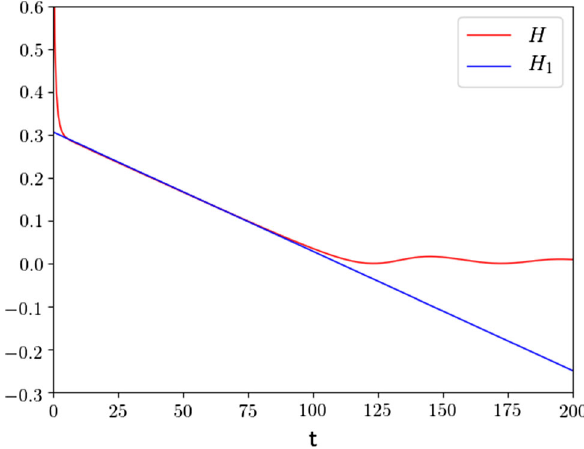
Fig. 1 It is shown in red the exact numerical solution of Eq. (19) for β = − 10, H ( t ) . Plotted in blue is the perturbative solution (22), H The initial condition is chosen as H ( 0 ) = 1, ˙ H ( 0 ) = − 1 . 66666, while the constant t 0 = 110 . 2 in (22) is fixed by best fitting. It can be seen that the perturbative solution does not agree with the field equation towards the singularity for decreasing time. Both solutions also show disagreement in the linearized weak-field regime. On the other hand, both solutions show very good agreement in the slow-roll regime